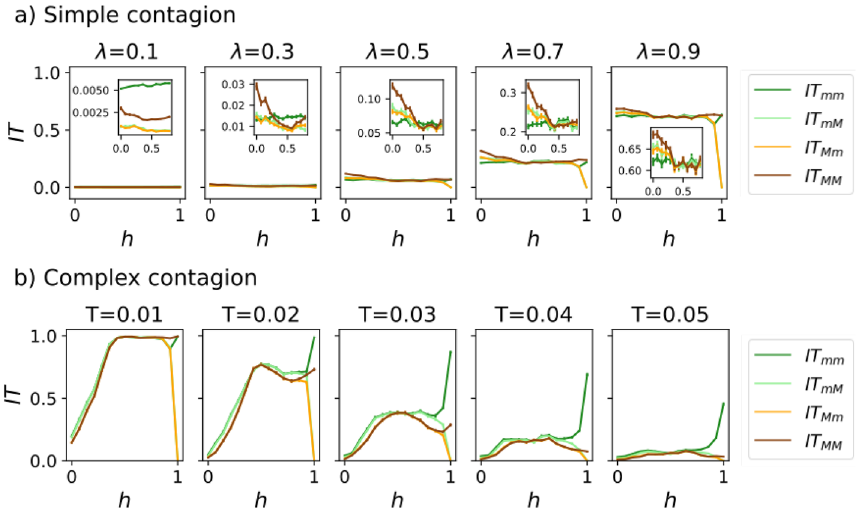
Figure 3. Information transmission observables as a function of the homophily parameter h . The chosen dynamics are Simple Contagion in panel ( a ) and Complex Contagion in panel ( b ). Each column shows a different infectivity (cid:31) or threshold T . The inset in panel a depicts the same IT observables as a function of the homophily parameter, but with a rescaled y-axis, so that variations among the curves are visible. To improve clarity, we have removed the values corresponding to h > 0.85 from the inset. In the legend, the subindexes indicate source and target groups respectively (for example, IT mM indicates that the source group is the minority and the target group is the majority). Parameters used: N = 1000 nodes, m = 1 , minority fraction f a = 0.2 , M = 1000 realizations (varying both the network structure and the location of the